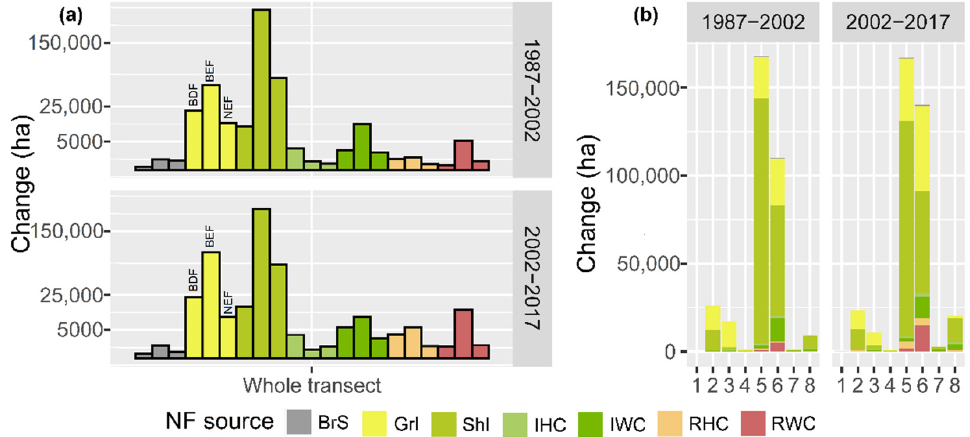
Figure 4. ( a ) NF transitions change area by source category and forest type for the whole transect. Colors denote source categories (e.g., yellow = grasslands), while the three consecutive bars represent each target forest (BDF, BEF, and NEF). ( b ) NF transition area disaggregated by BR, referenced by the numbers in Table 1.